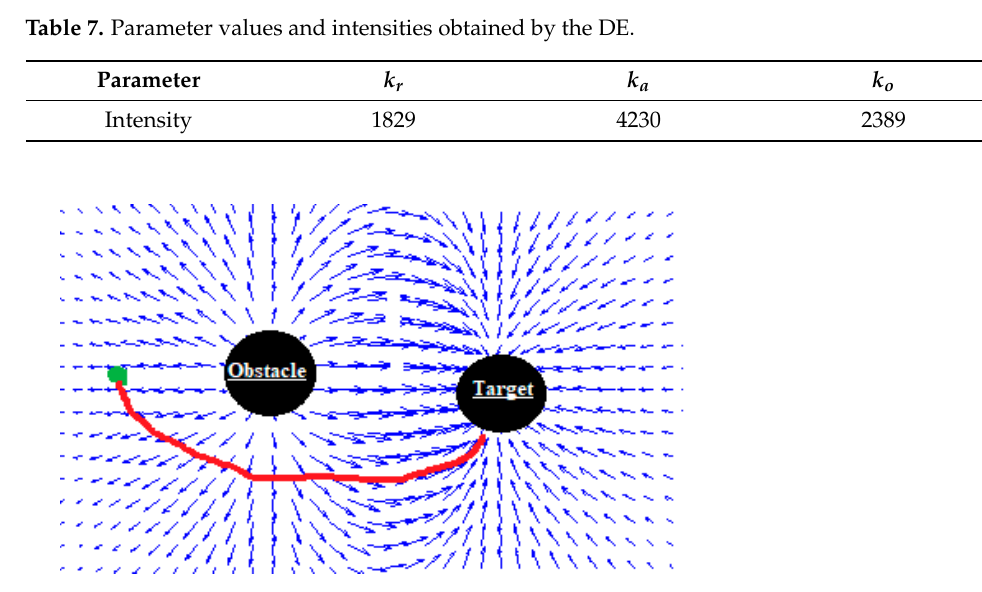
Figure 12. Trajectory and collision-free path performed by the APF for the parameters in Table 6.